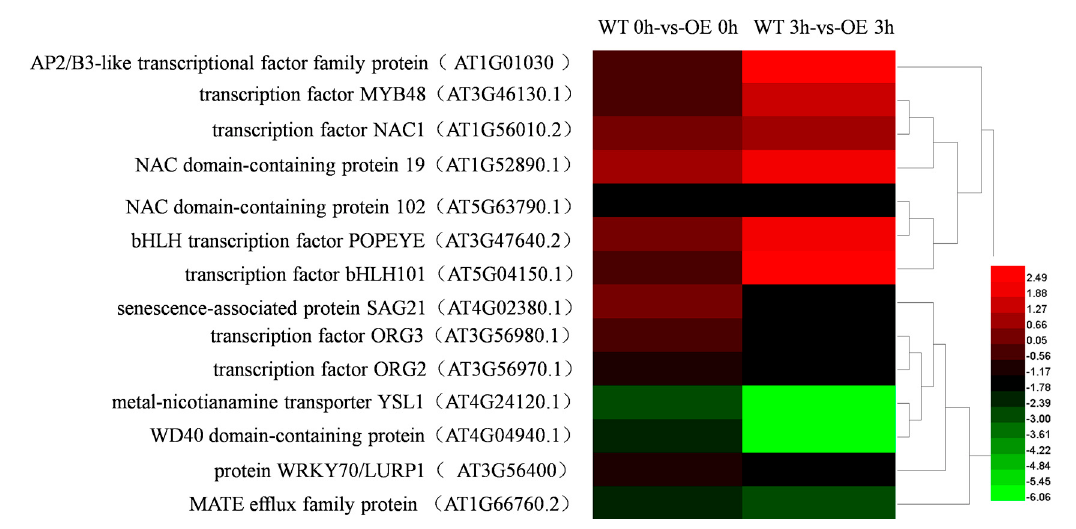
Figure 7. Expression analysis of differentially expressed Transcription Factors (TFs) during stress exposure.